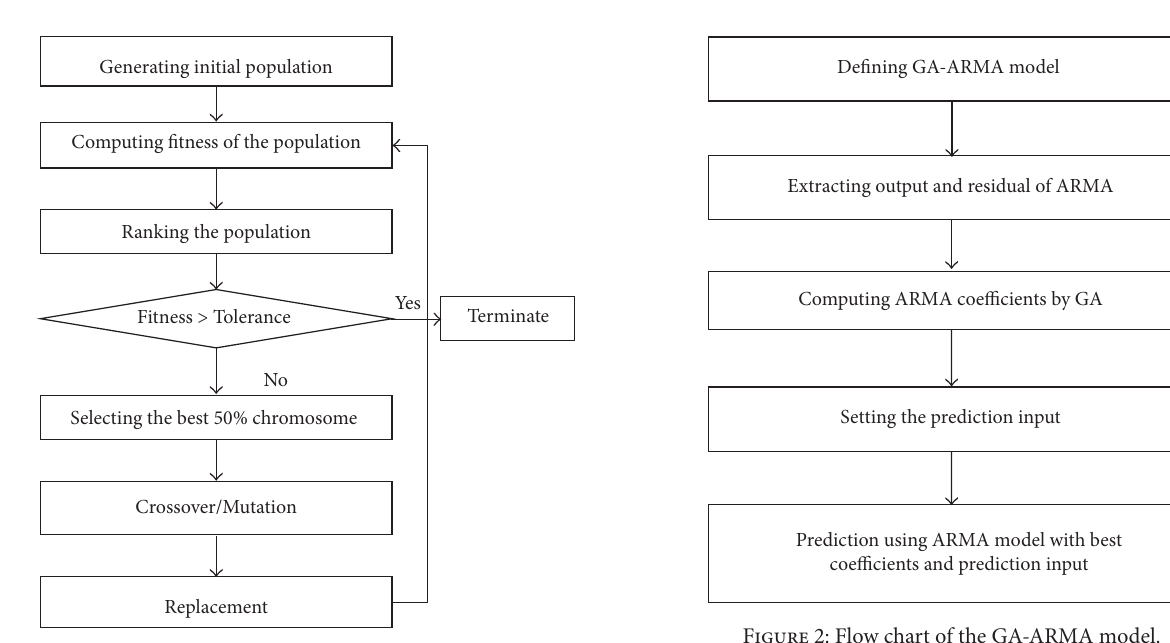
Figure 1: Flow chart of genetic algorithm.